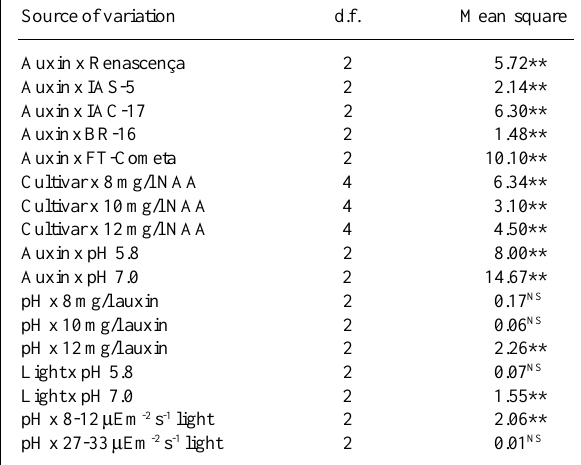
Table II - Analysis of variance for the partition of degrees of freedom (d.f.) in auxin levels x cultivars, cultivars x auxin levels,